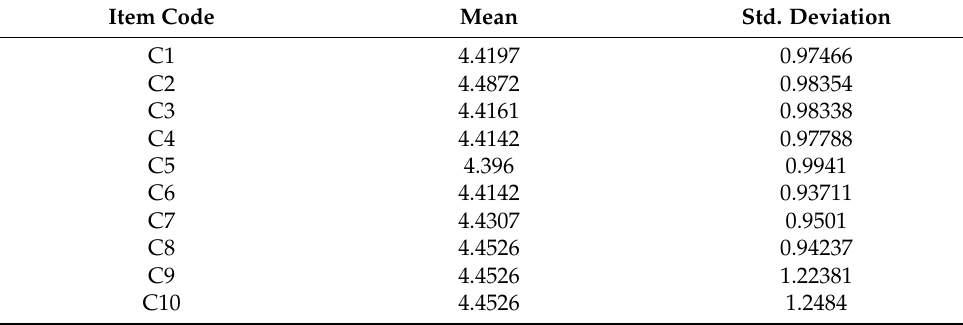
Table 3. Descriptive statistics of